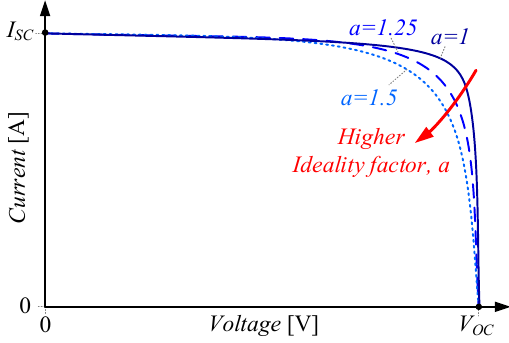
Figure 2. Changes in I–V curves according to the diode ideality factor.